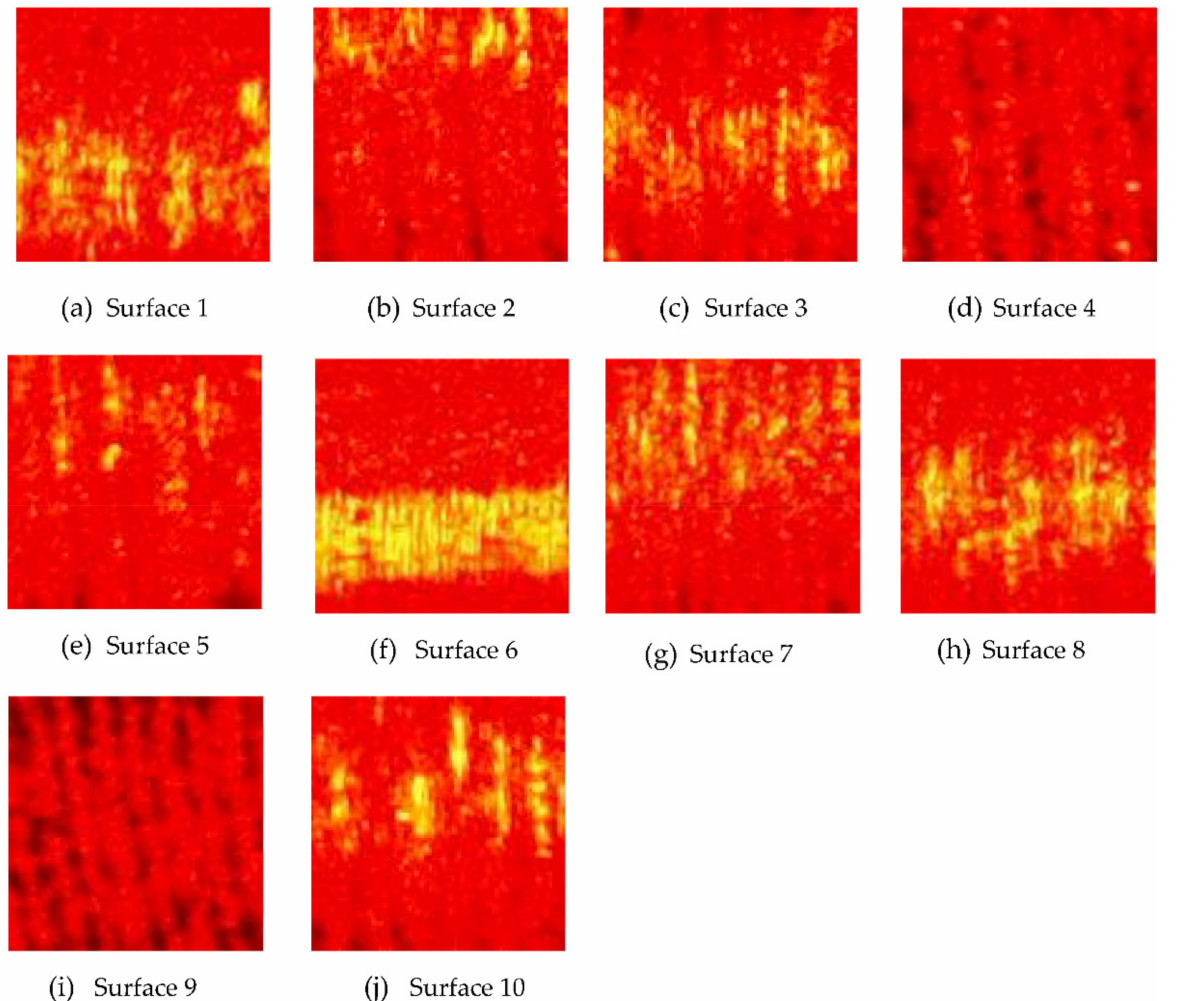
Figure 5. ( a – j ) are the cropped laser speckle pattern images for each surface at illumination angle of 45 ◦ , f number of 16 and shutter speed of 1/100